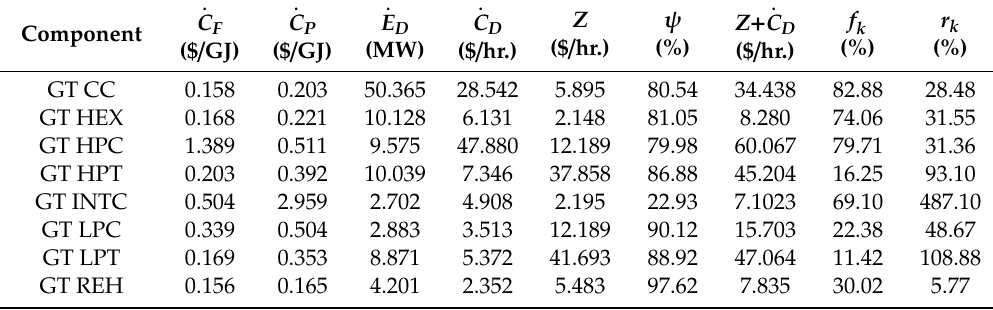
Table 6. Exergoeconomic parameters for the gas turbine plant.